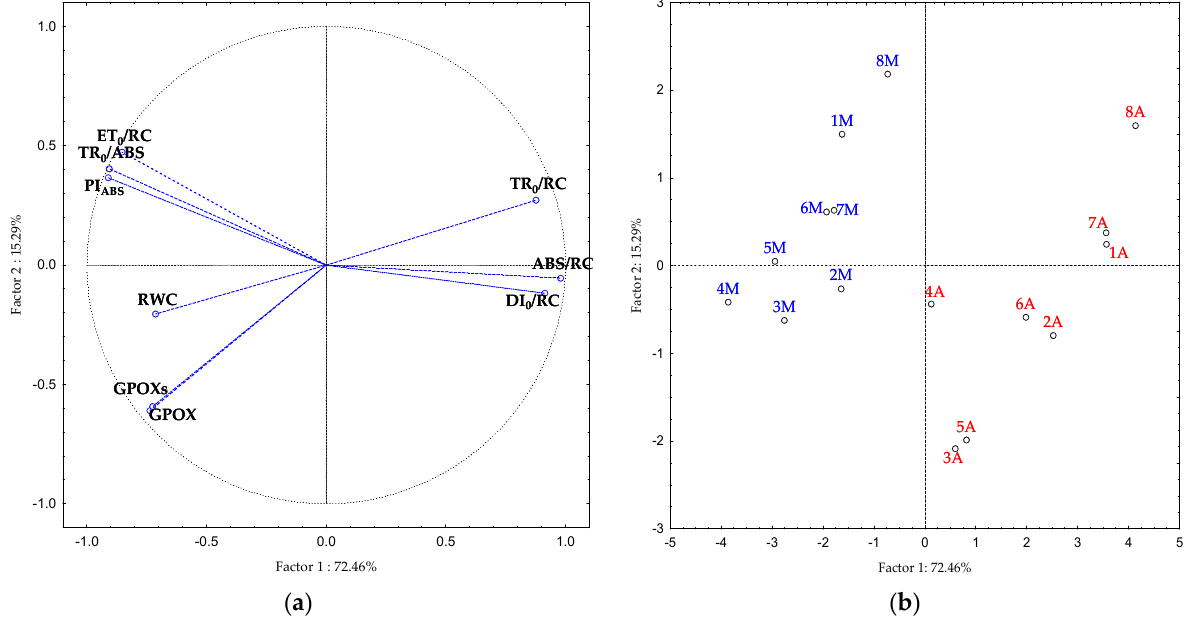
Figure 4. Biplots are constructed based on the results of the principal component analysis for thirteen parameters ( a ) and eight sunflower hybrids ( b ). M (blue) indicates measurements in the morning and A (red) indicates measurements in the